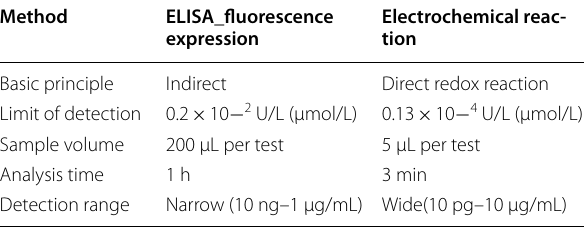
Table 1 NWA effectiveness compared with conventional ELISA